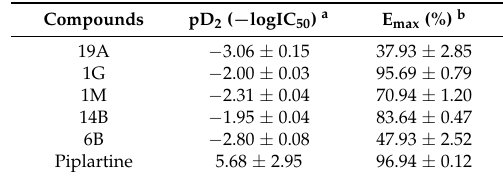
Table 3. Determination of pD 2 and E max for the cytotoxic effect of piplartine and its analogues in murine fibroblast (NIH-3T3)